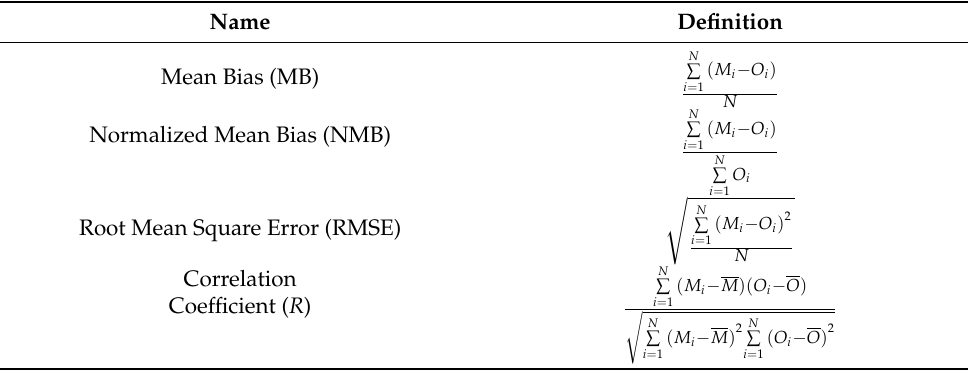
Table 2. Statistical measures of model